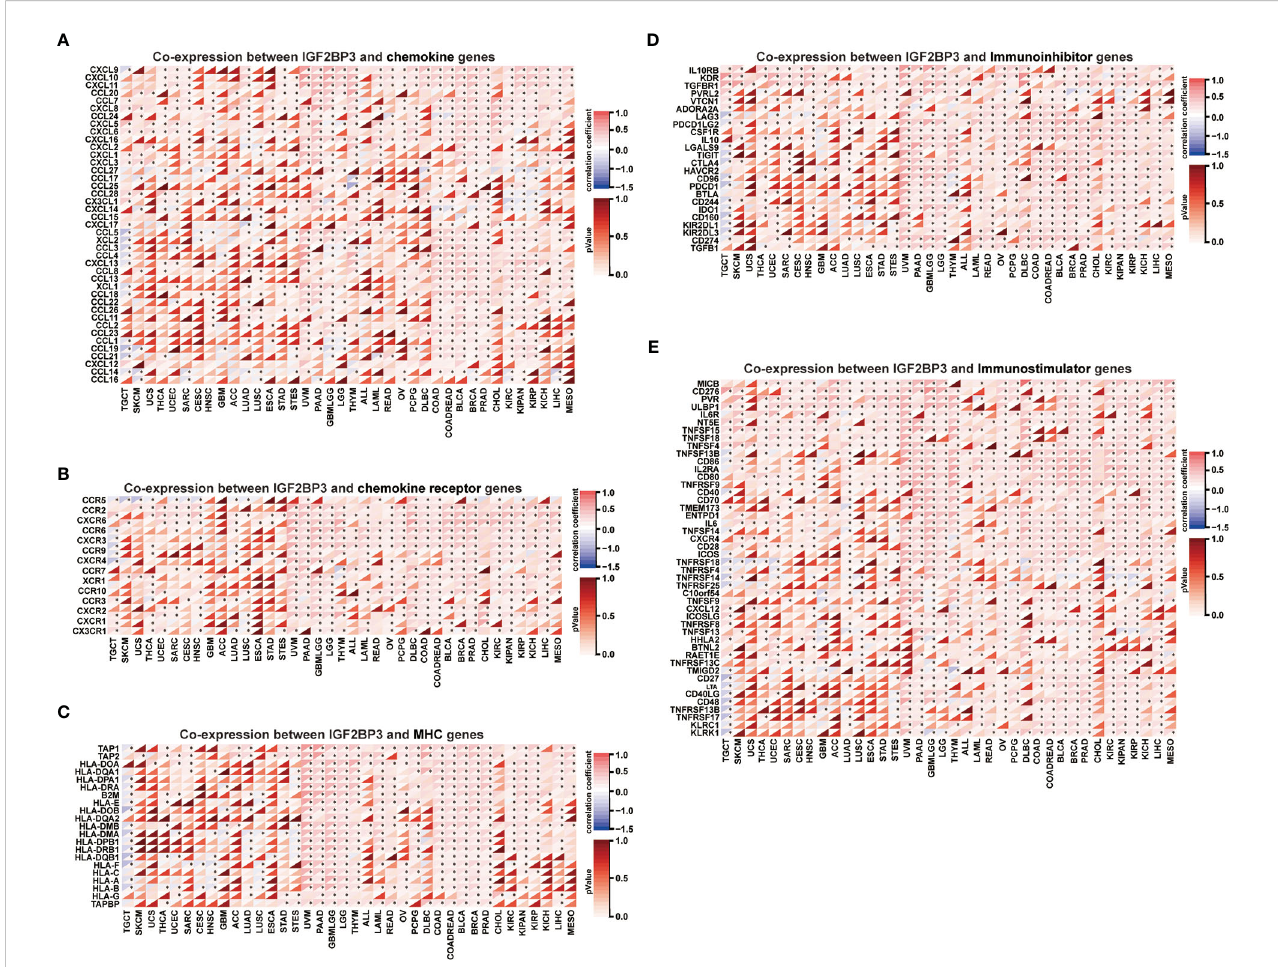
FIGURE 10 Co-expression of IGF2BP3 and immune-related genes in pan-cancer. Heatmaps indicating the co-expression of IGF2BP3 with immune-relevant genes in pan-cancer, including chemokine genes (A) , chemokine-receptor genes (B) , MHC molecules (C) , immunoinhibitors (D) , and immunostimulators (E) . *p- value < 0.05, **p-value < 0.01, ***p-value < 0.001, and ****p-value <